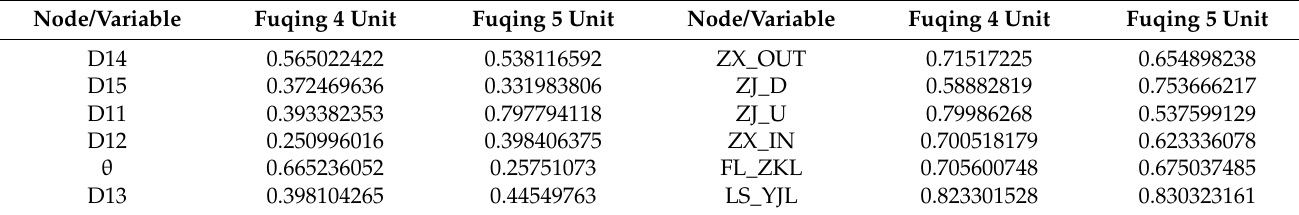
Table 4. Key variable values after normalization of Fuqing 4, 5